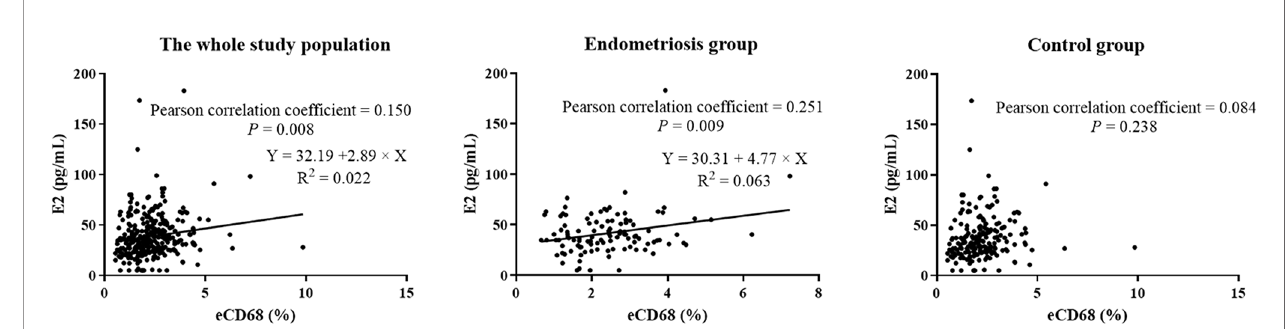
FIGURE 1 | Weak correlation between E2 and endometrial CD68 in the study